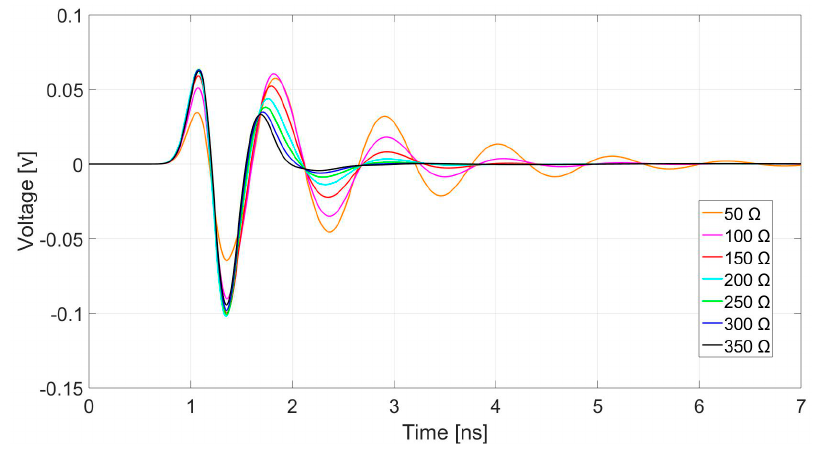
Figure 6. The effect of Antenna input impedance on late-time ringing.